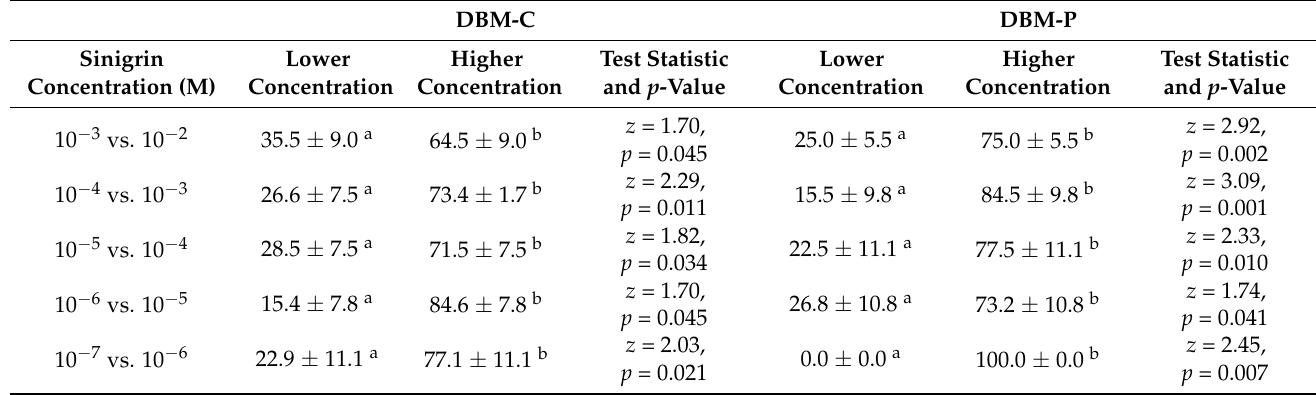
Table 3. Oviposition preference of P . xylostella strains reared on cabbage (DBM-C) and on artificial diet (DBM-G88) on filter paper impregnated with different concentrations of sinigrin. Data were analyzed using a one-tailed, two-sample test of proportions ( p ≤ 0.05). Only the comparisons were more than one egg was laid on filter paper were considered (n = 3–17). For each comparison, means within a row followed by different superscript letters are significantly different.